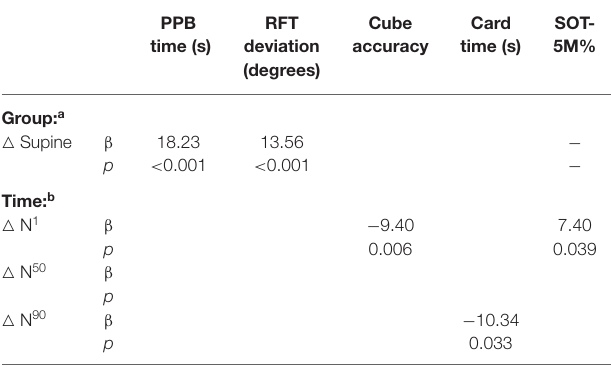
TABLE 4 | Effects of subject position and time on cognitive performance in normative control subjects.